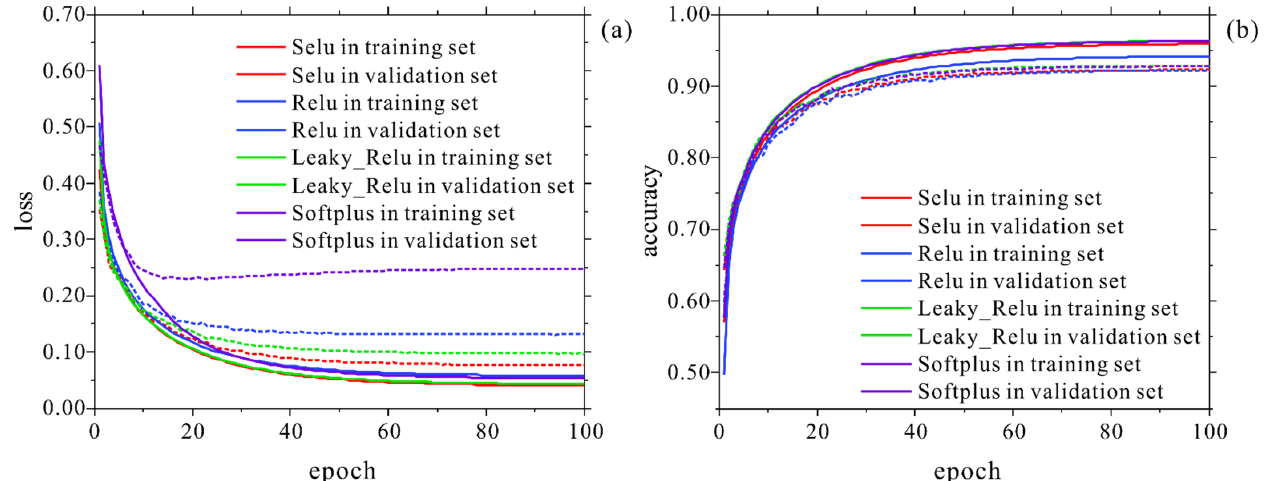
Figure 8. The model ′ s performance curve with different activation functions. ( a ) loss curve, ( b ) accuracy curve.